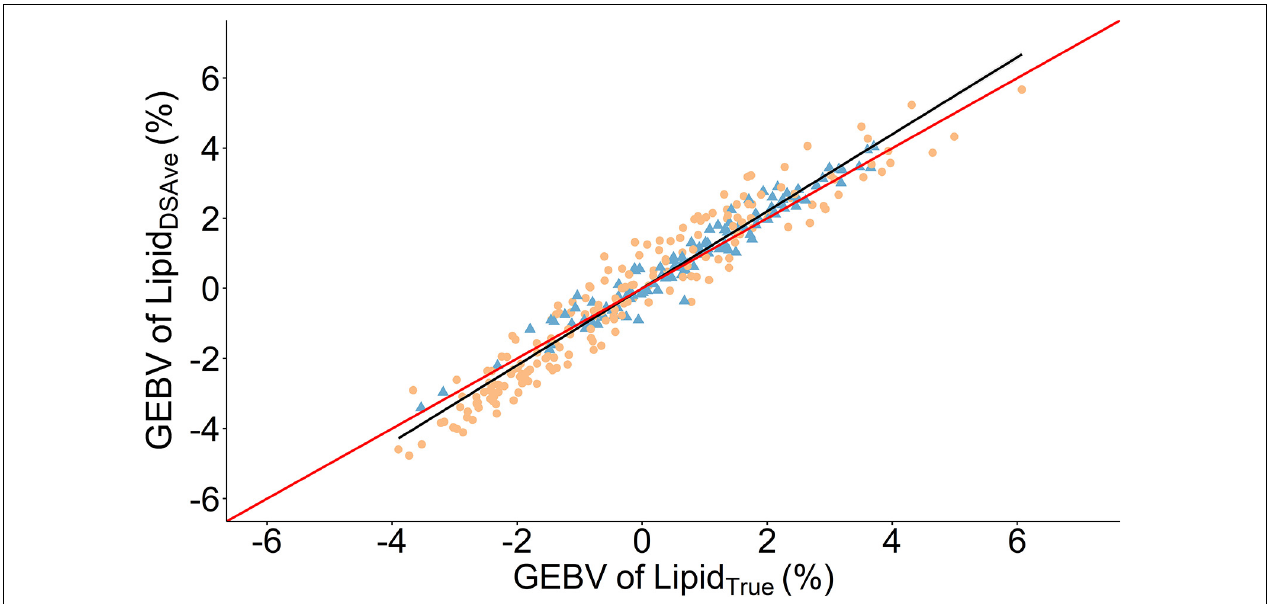
FIGURE 3 | Scatter plot of the relationship between genomic estimated breeding values (GEBVS) of the mean fillet lipid percentage of four measurements using a handheld dielectric spectrometer (Lipid DSAve ) and the laboratory reference method (Lipid True ). A linear regression is given as the solid black line with the 95% confidence interval is gray shading. The solid red line is the line of unity. Round orange points denote 2017 cohort and triangle blue points are the 2016